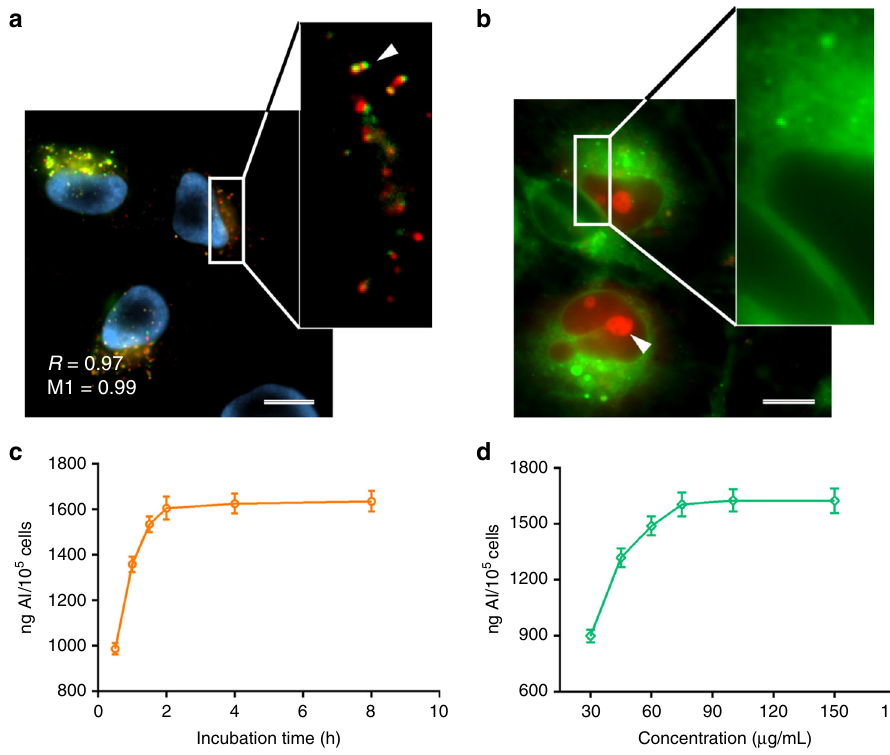
Fig. 3 Cellular internalization of SC@FNPCN-333 by HeLa cells. a 100× microscopy images of SC@FNPCN-333 (75 µ g mL − 1 ) incubated with HeLa cells for 2 h, then stained with the nuclear marker Hoechst 33,342 and LysoTracker red. Cell nuclei, SC@FNPCN-333 and LysoTracker red labeled acidic